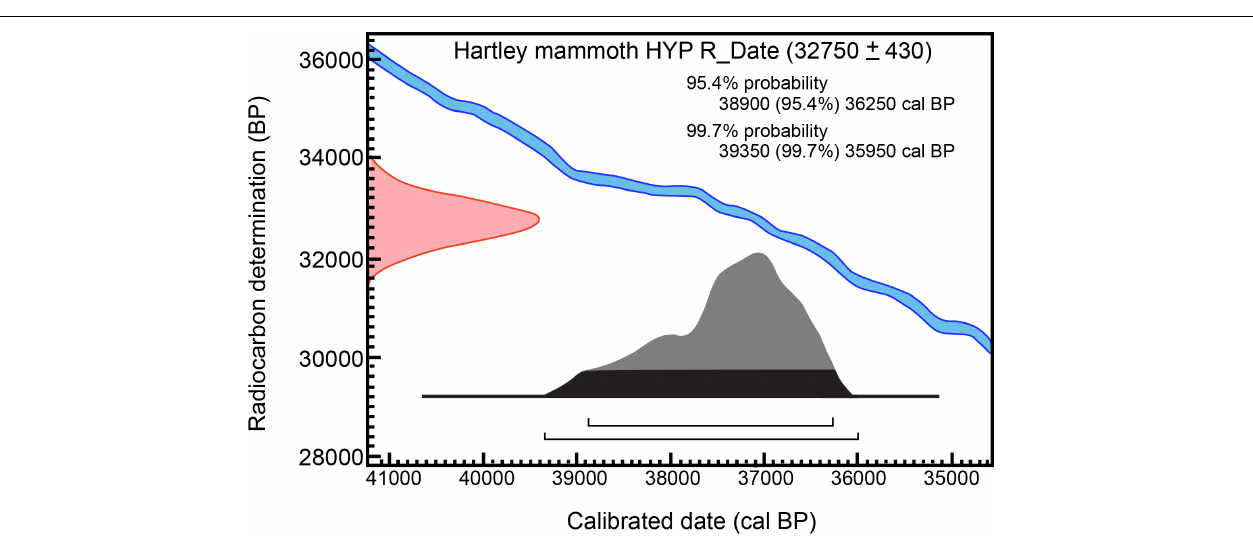
FIGURE 5 | Calibration of 14 C measurement on hydroxyproline from Hartley mammoth bone collagen: 32,750 ± 430 RC yr BP (OxA-X-2737-65) OxCal v4.4.4; atmospheric data from Reimer